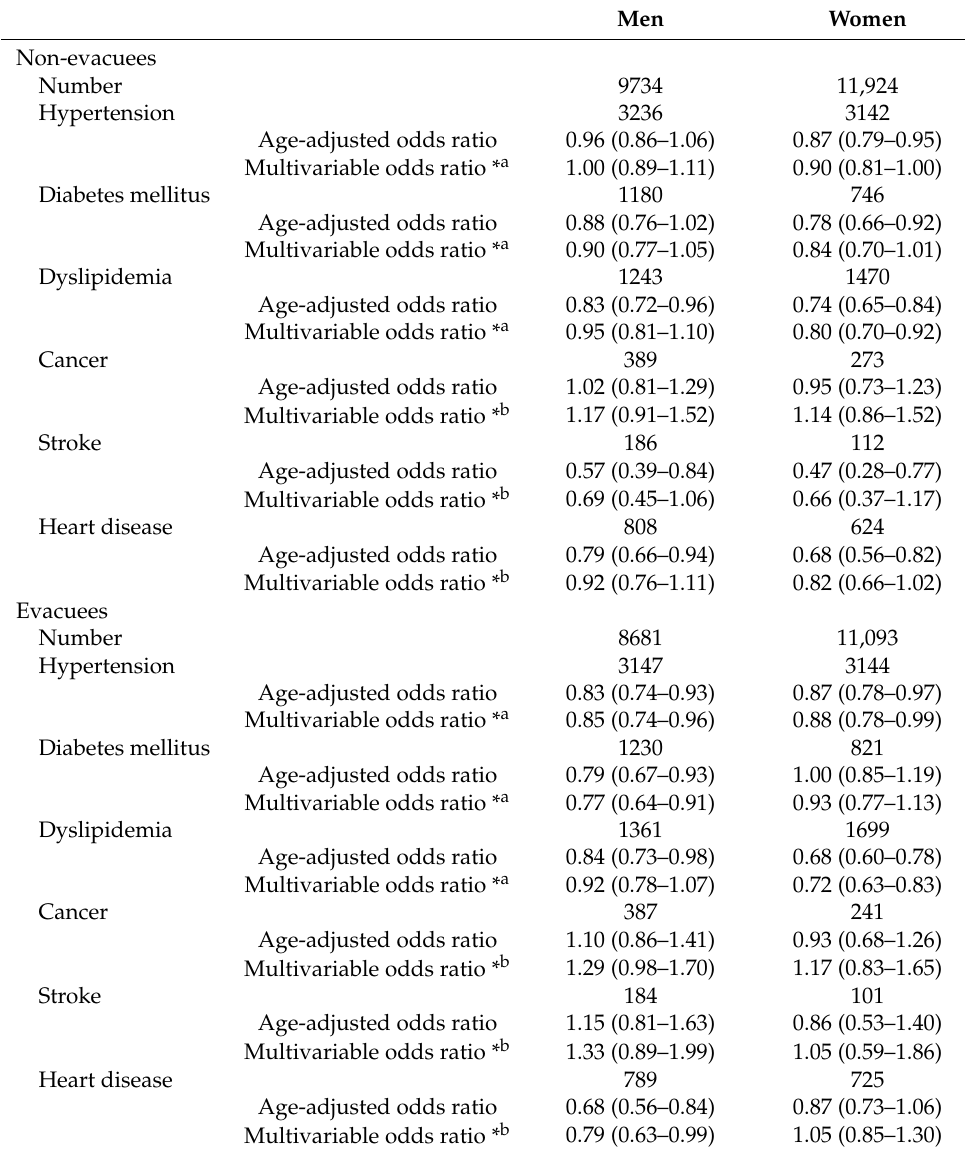
Table 3. Gender-specific age-adjusted and multivariable odds ratios of lifestyle diseases for those who laugh every day compared to those who do not laugh every day stratified by experience of evacuation. Men